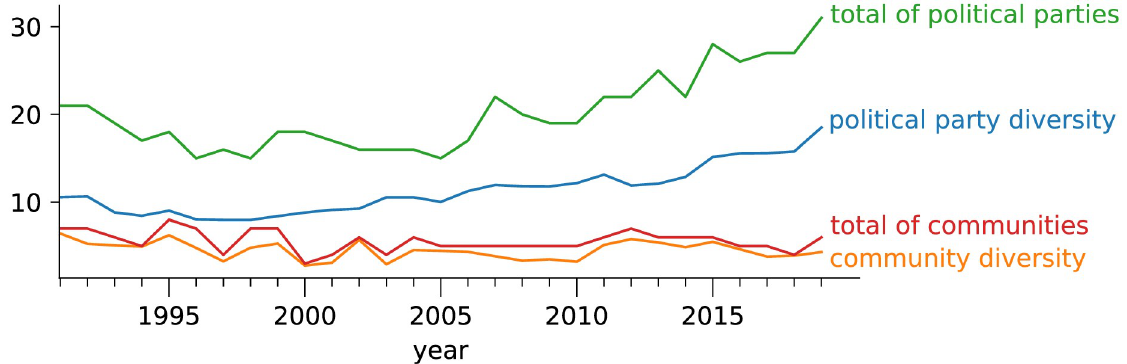
Fig 9. Size evolution of political parties and network communities. Even though the Brazilian Chamber of Deputies is represented by 29 political parties, the effective number of network communities (community diversity) in 2019 is only 3.37.